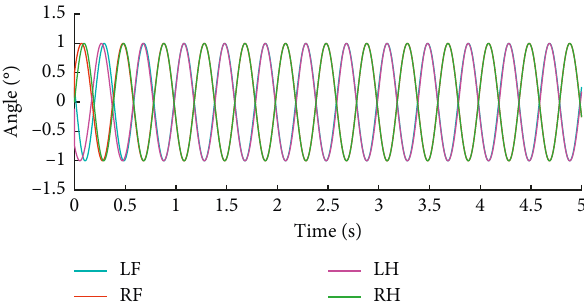
Figure 14: Relative phase relation of the walk gait.